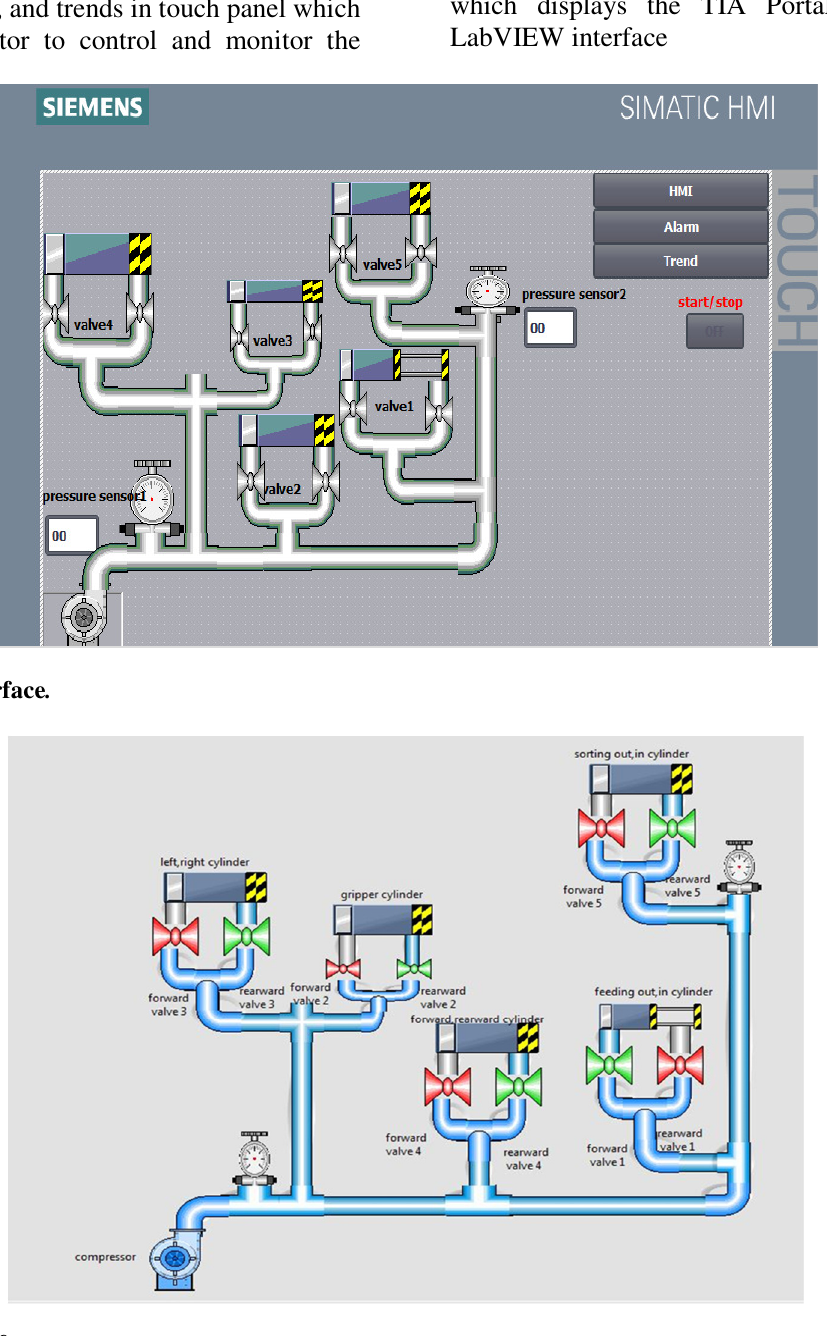
Fig. 16. Two HMI result of feeding unit start